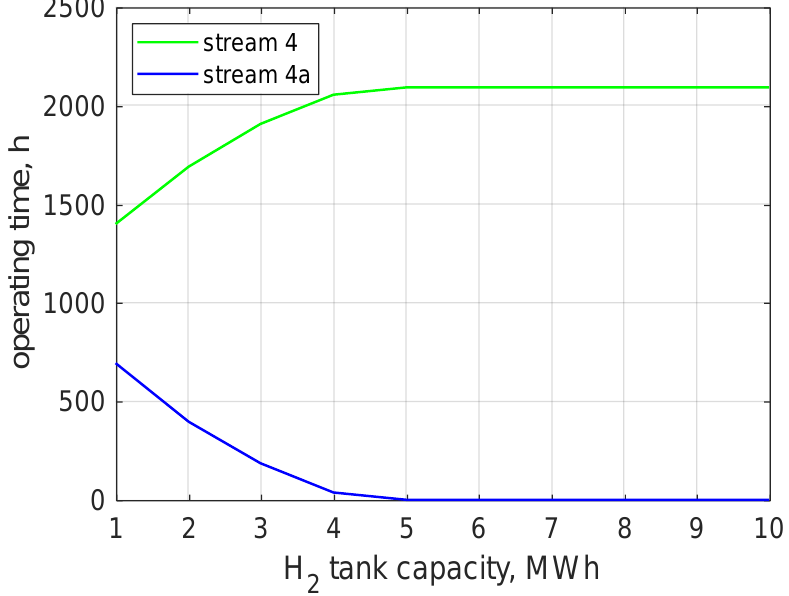
Figure 4. Graph showing the operating time for the two variants of the hydrogen generator working as a function of the hydrogen buffer capacity.